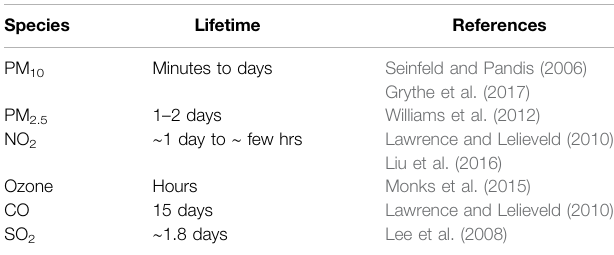
TABLE 4 | Lifetimes of particulate matter (PM) and various gaseous species. Species